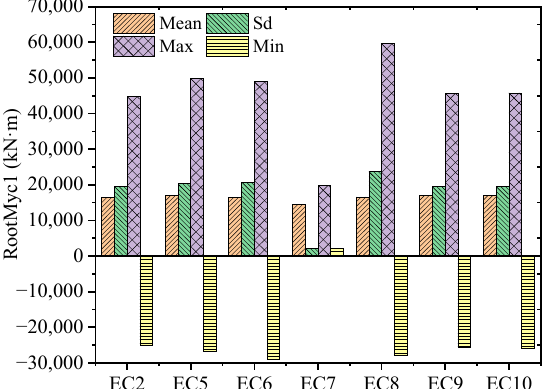
Figure 14. Statistics of the